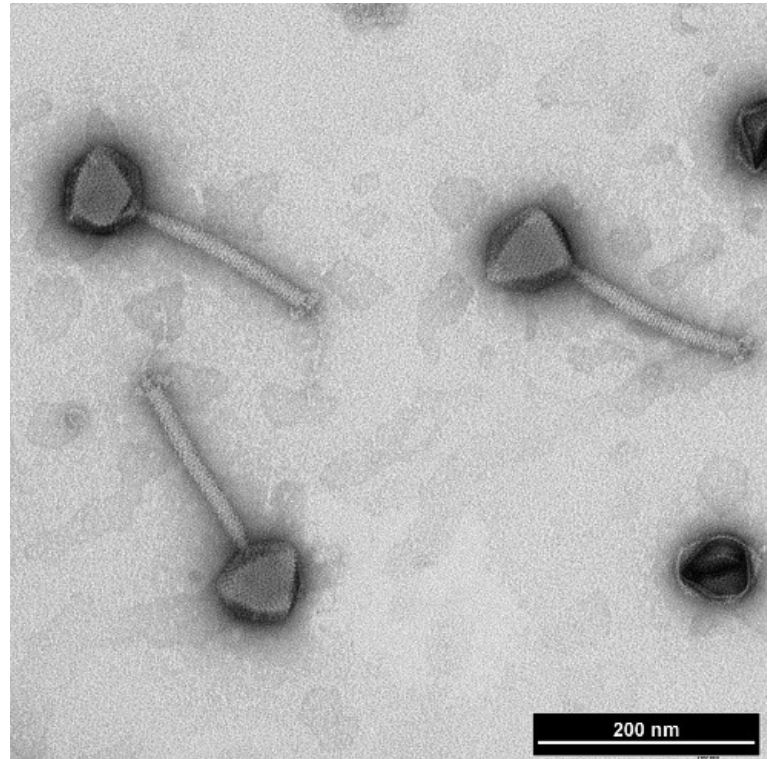
Figure 2. Transmission electron micrograph of the Twort-like phage vB_BceM_Bc431v3. Phage particles display isometric heads 85.4 ± 3 nm in diameter with individual capsomers. The phage possesses a long contractile tail 180 ± 3 nm in length by 12 ± 4 nm in